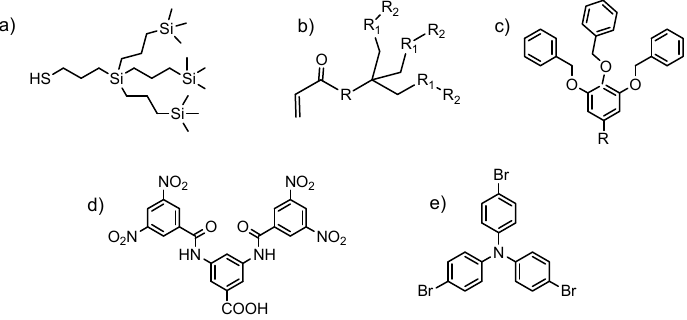
Figure 2. Dendrons used as building blocks, spacer arms, or functionalizing agents: ( a ) carbosilane dendrons; ( b ) Newkome-type dendrons; ( c ) Fréchet-type dendrons; ( d ) Kakimoto-type dendrons: ( e ) Triarylamine dendrons.